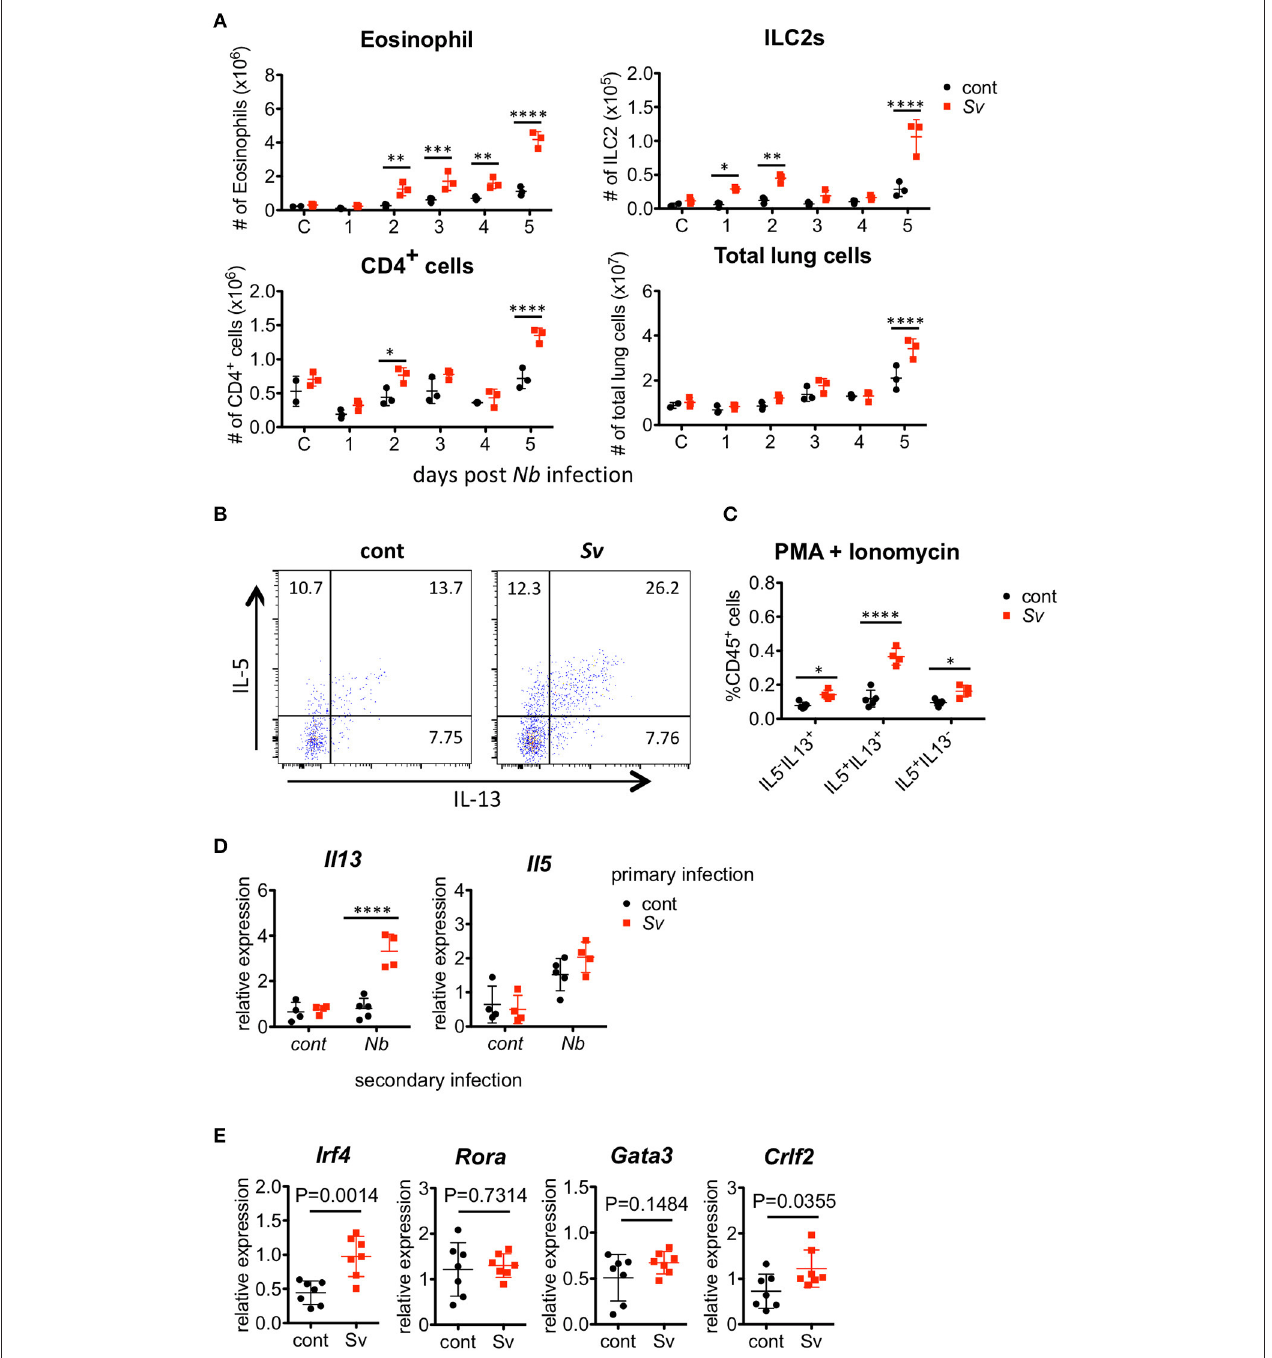
FIGURE 5 | Strongyloides venezuelensis -infection induces highly reactive ILC2s in the lungs. (A) S. venezuelensis -infected (Sv) or uninfected control (cont) mice ( n = 3) were inoculated with 500 N. brasiliensis L3 (Nb). Cell populations of lung cells at the indicated days were analyzed by flow cytometry (SP6800) ( Figure S6 ). (B) Eight weeks after S. venezuelensis infection, lung cells were stimulated with PMA and ionomycin for 3h in the presence of brefeldin A. Intracellular IL-5 and IL-13 in ILC2s were analyzed by flow cytometry (SP6800). ILC2s were gated on Fixable Viability Dye − CD45 + Lin(CD3, CD4, CD8, CD11b, B220, NK1.1, IgE, Gr-1) − ST2 + Sca-1 + Thy1.2 + cells. (C) The proportions of IL-5 + IL-13 − , IL-5 − IL-13 + , and IL-5 + IL-13 + ILC2s in the population of CD45 + cells ( n = 4–5). (D) Lung ILC2s were sorted from S. venezuelensis -infected or uninfected mice ( n = 4–5) before or 2 days after infection with N. brasiliensis L3. The expression levels of Il5 and Il13 mRNA were analyzed by Q-PCR. Data are representative of two independent experiments that had similar results (Mean ± SD). (E) The expression levels of transcription factors and TSLPR (Crlf2) in lung ILC2s were analyzed by Q-PCR. Statistical analyses were performed using Student’s t -tests. Data are representative of two independent experiments (Mean ± SD).